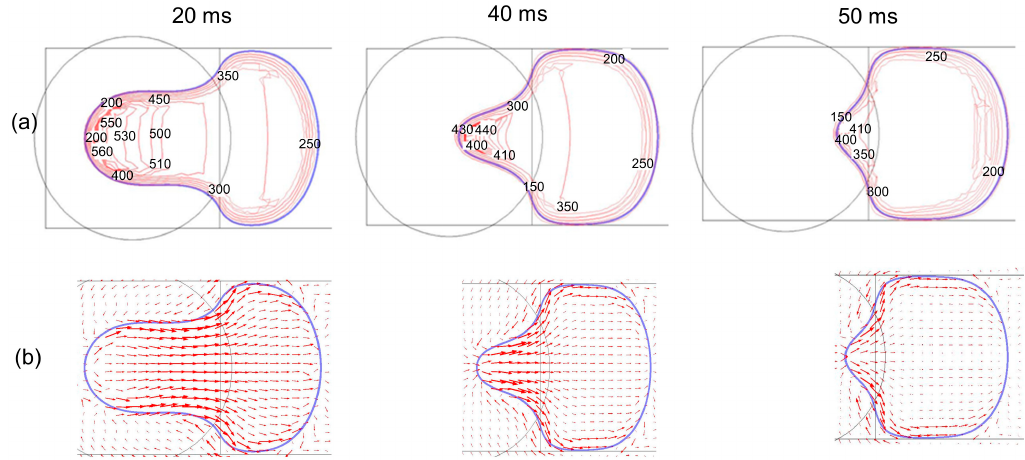
Figure A3. ( a ) Pressure distribution inside droplet on square electrode from simulation and (pressure contours in MPa); ( b ) velocity field inside droplet from simulation. Interface shown in blue and initial droplet shape is shown in black.